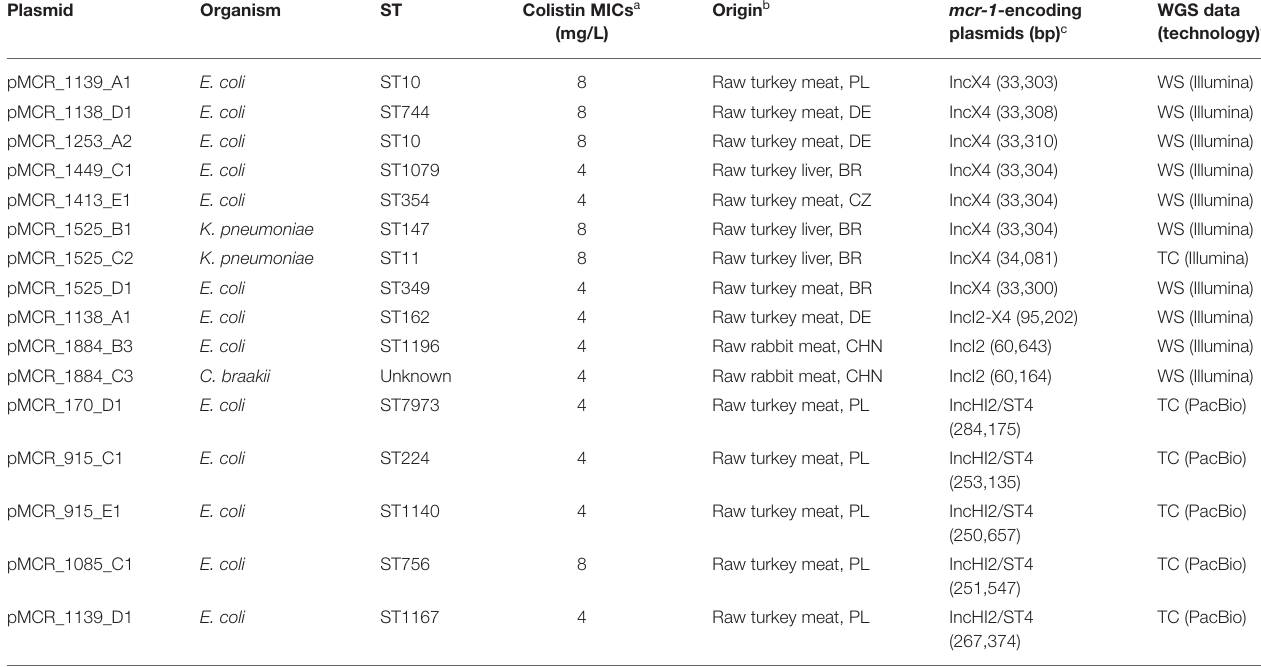
TABLE 1 | The characteristics and origin of mcr-1 encoding plasmids. Plasmid Organism ST Colistin MICs a